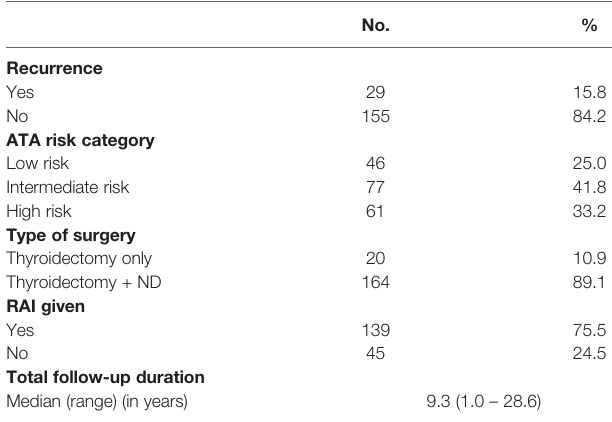
TABLE 1 | Clinico-pathological and molecular characteristics of Papillary thyroid